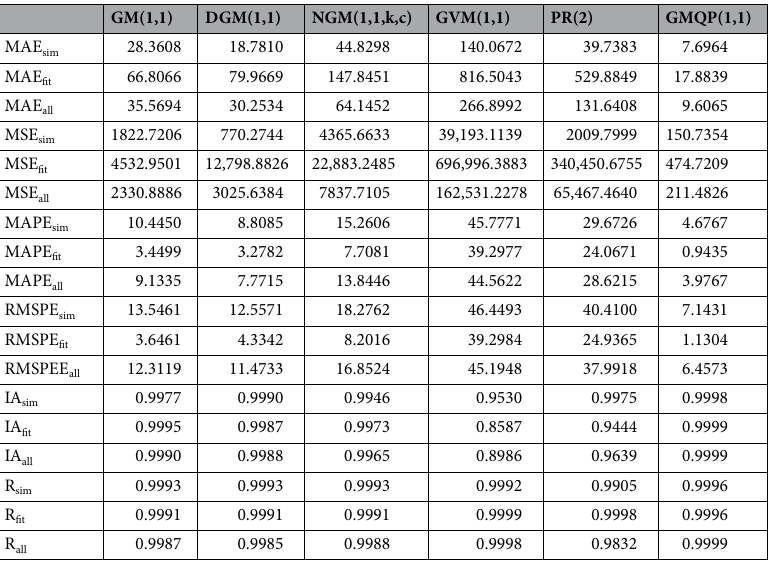
Table 17. The evaluation measures of different forecasting models in the recovered